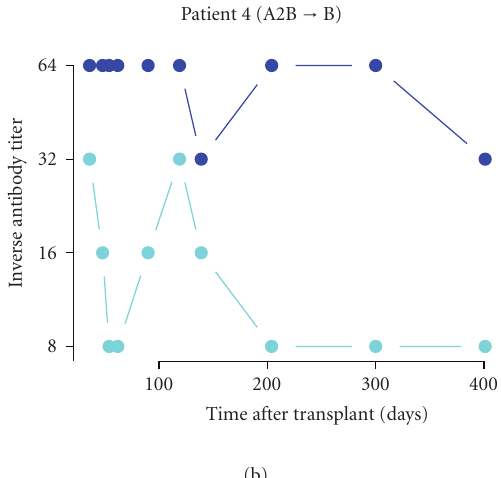
Figure 2: Perioperative isoagglutinin titers (early phase, panel (a); late phase, panel (b)). Inverse antibody titers of type Anti-A1, -A2, and B are shown in dark blue, light blue, and green, respectively, on a logarithmic scale. The time scale indicates days after transplant (patients 1, 2, and 4) or days post surgery (patient 3). IA: immunoadsorption; PP: plasmapheresis; RIT: